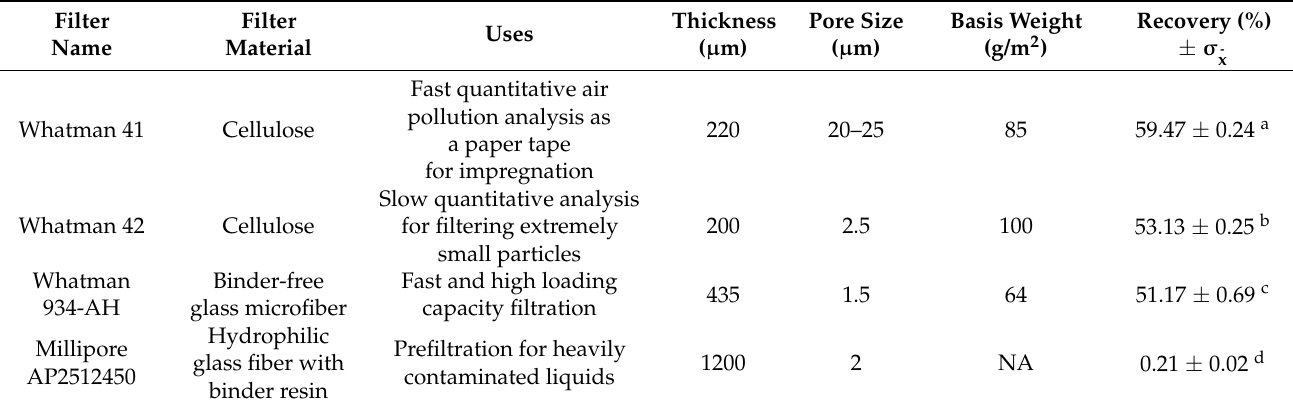
Table 1. Properties of filters used in this study and their observed recoveries of chemicals after impregnation.